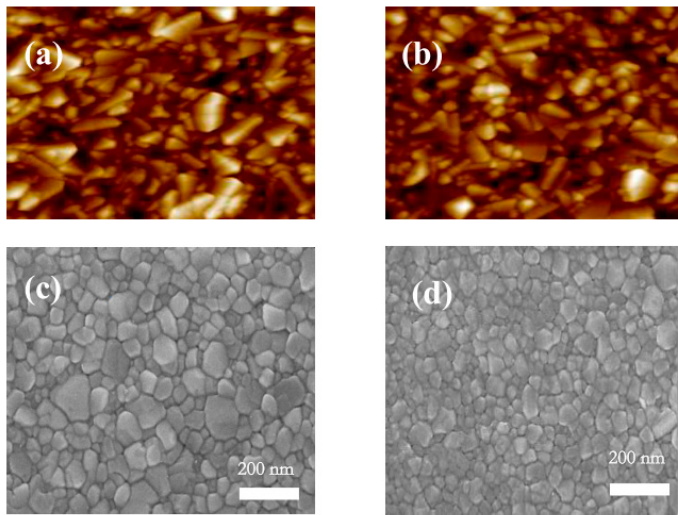
Figure 4. AFM images of surface morphology of FTO substrate without and with sputtered SnO 2 film ( a , b ), and SEM images of perovskite films deposited on FTO substrate without and with reactive-sputtered SnO 2 film ( c , d ).